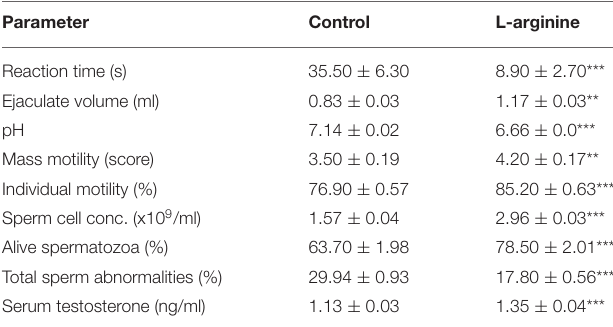
TABLE 2 | Reaction time, semen parameters and testosterone concentrations in the control and L-arginine treated rams ( n = 5/group, mean ± SEM).